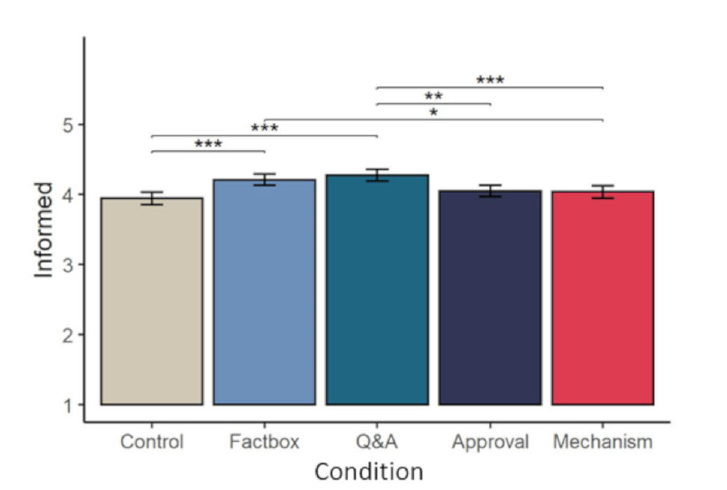
Figure 2. Mean (95% CI) reported level of feeling informed regarding vaccination decision across experimental conditions. Brackets and asterisks indicate significant pairwise differences. * p < 0.05, ** p < 0.01, *** p <